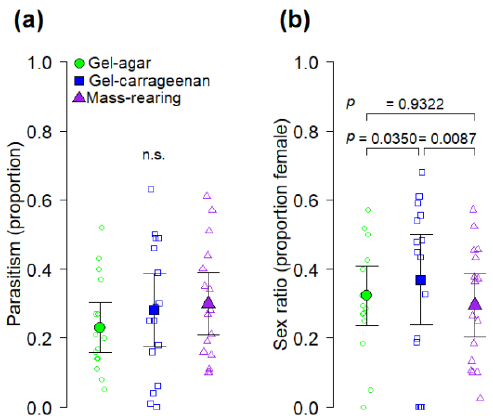
Figure 4. E ff ects of host A. ludens larval diet (gel-agar, gel-carrageenan and mass-rearing) on ( a ) parasitism and ( b ) sex ratio of Diachasmimorpha longicaudata . Solid symbols indicate mean values and error bars show 95% CI; open symbols indicate jittered data points. The p values of Tukey contrasts among diets are shown within each figure panel; n.s. = no significant di ff erences ( p > 0.05).